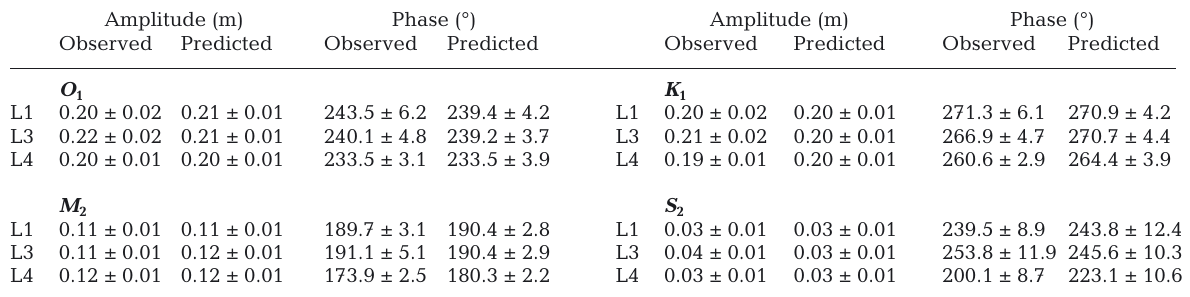
Table 1. Harmonic analysis of observed and predicted water level time series with 95% confidence intervals at all sampled stations inside the model domain (L1, L3 and L4; see Fig. 2). Results are shown for the 4 main tidal constituents (O 1 : principal lunar diurnal; K 1 : lunisolar diurnal; M 2 : principal lunar semidiurnal; S 2 : principal solar semidiurnal)